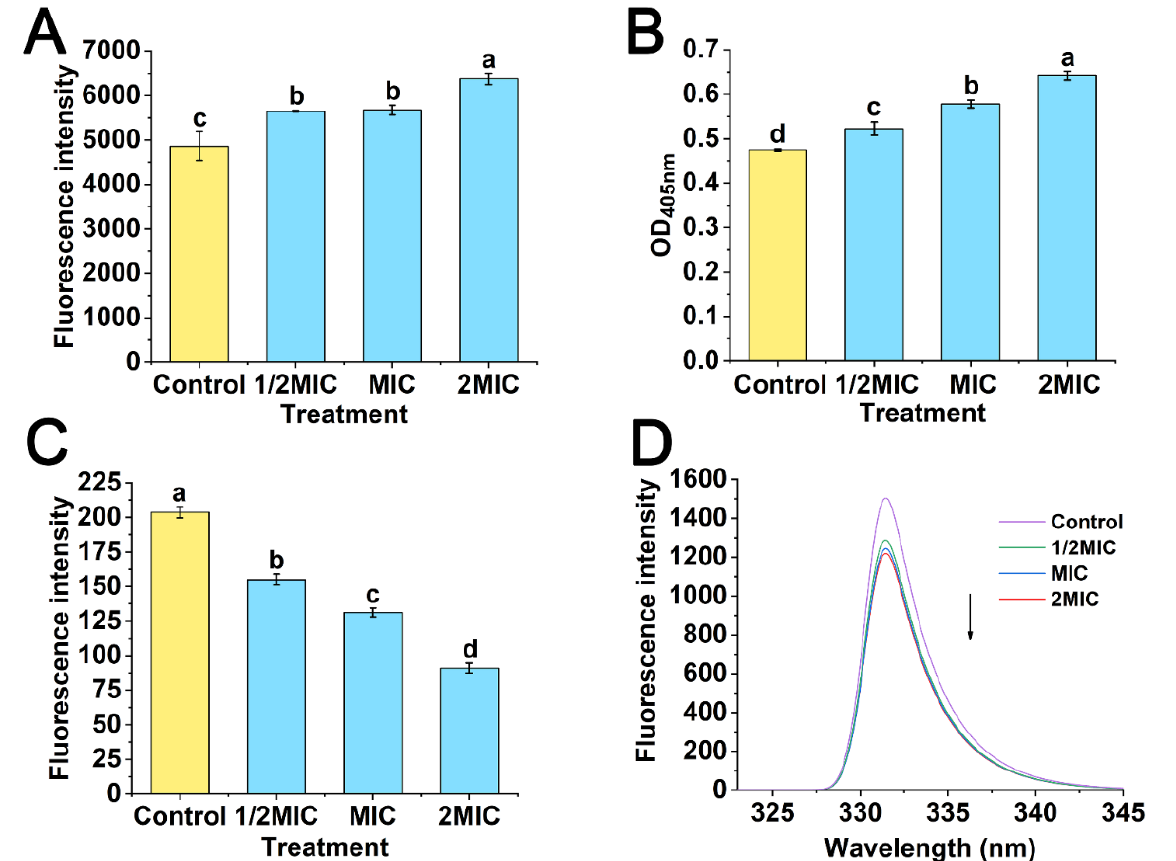
Figure 9. The effects of Polygonum orientale essential oil (concentration: 1/2MIC, MIC, and 2MIC) on cell membrane integrity ( A ), cell membrane permeability ( B ), membrane potential ( C ) and fluores- cence spectra of membrane proteins ( D ) of Pectobacterium carotovorum subsp. carotovorum (Pcc). The control was Pcc treated with 2% DMSO. A significant difference was expressed ( p <